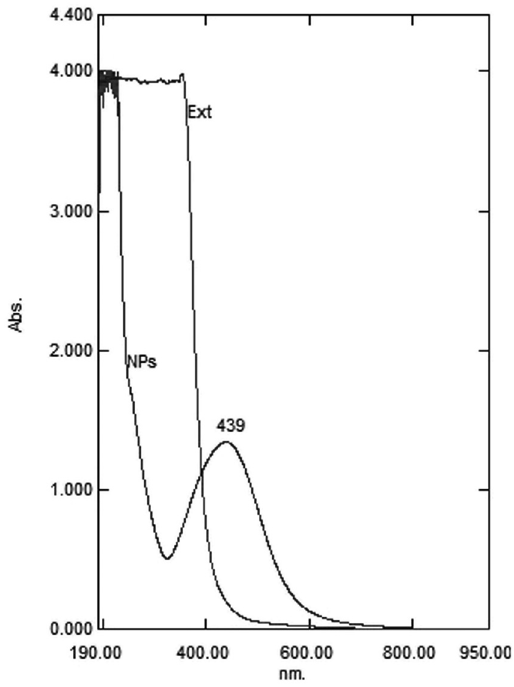
Figure 2: UV - Vis spectra of the synthesized Si - AgNPs, showing a broad absorption peak at ∼ 439 nm and the Si seed Figure 1: The formation of Si - AgNPs is indicated by color change. ( 1 ) AgNO ( 2 ) Si - extract: aqueous seed 3 : silver nitrate solution, extract of Sisymbrium irio , and ( 3 ) Si - AgNPs: a dark brown col - loidal mixture of green synthesized silver nanoparticles.